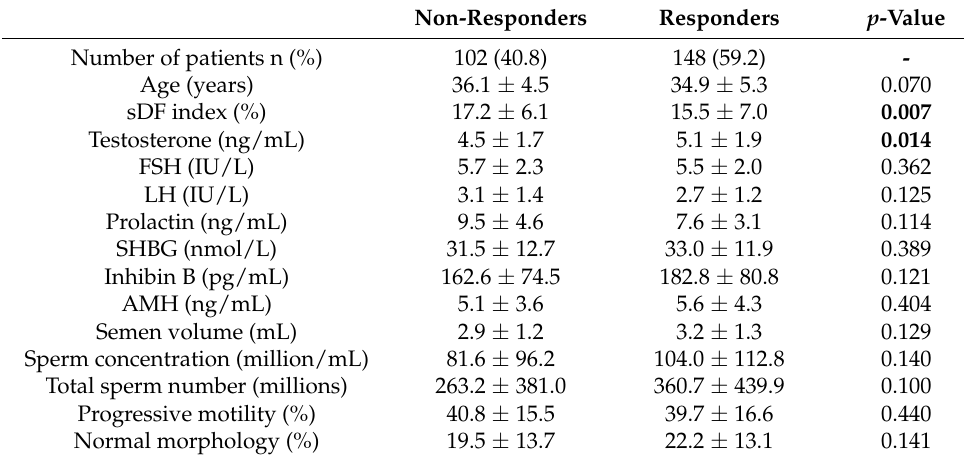
Table 5. Comparison between responders and non-responders based on sperm DNA fragmentation index, considering parameters after three months of follicle stimulating hormone (FSH) administra- tion using Mann–Whitney U -test. Data are expressed as mean ± standard deviation. Bold characters reported statistically significant parameters. Non-Responders Responders p -Value Number of patients n (%) 102 (40.8) 148